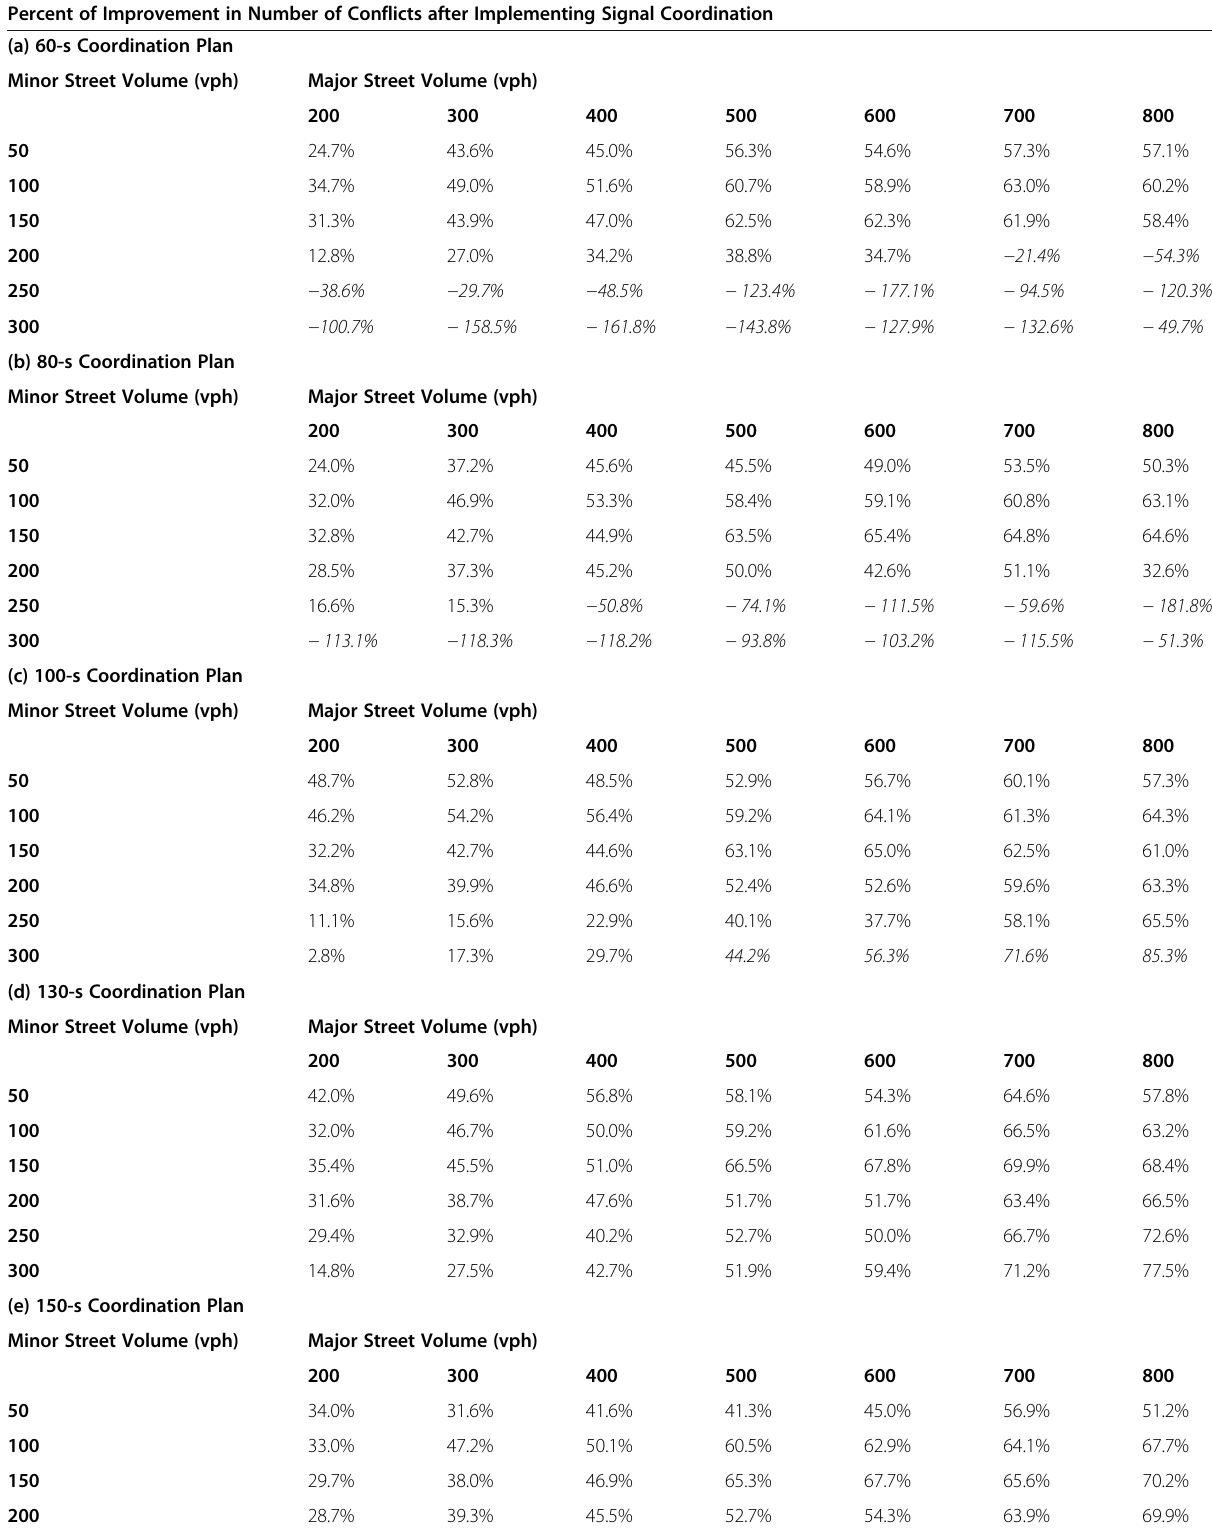
Table 2 Comparison of Simulated Number of Conflicts between Coordinated Signal Plans and Free Signal Operation Scheme at North McCarran